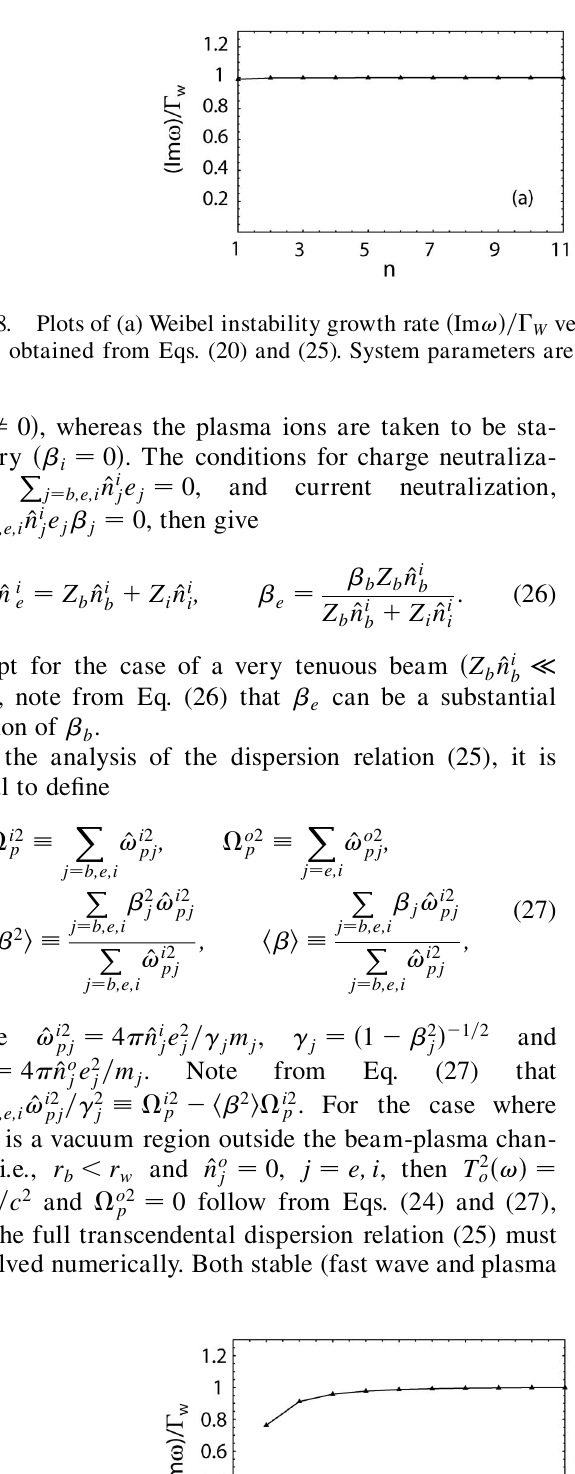
FIG. 9. Plots of (a) Weibel instability growth rate (cid:1) Im ! (cid:2) = " n (cid:7) 5 obtained from Eqs. (20) and (25). System parameters are r